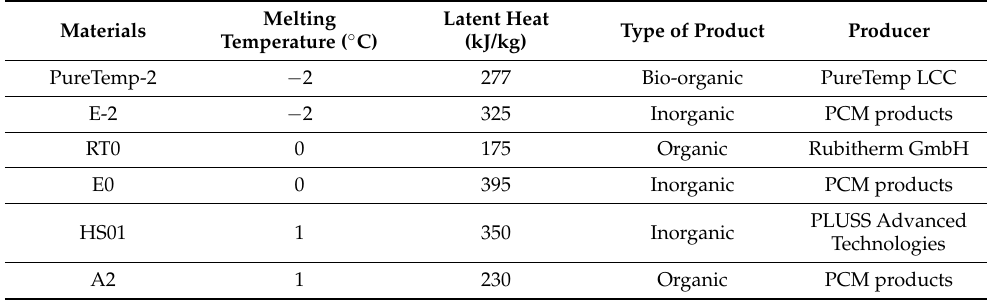
Table 3. Commercially available PCM for cold storage applications within temperature range of (–1 ◦ C to 10 ◦